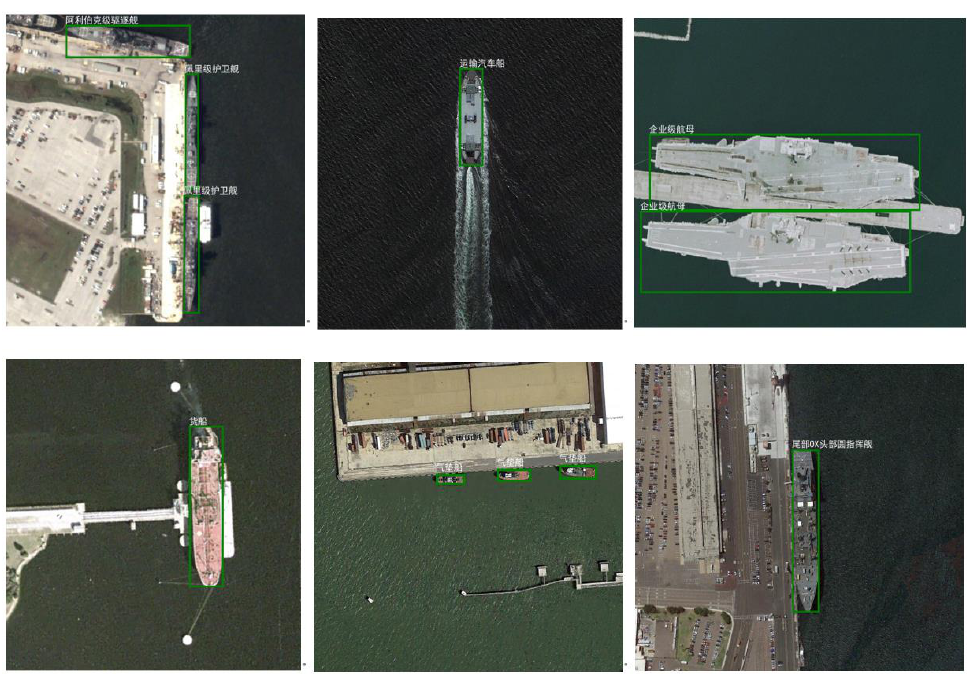
Figure 7. Some of the detection results obtained from the HRSC2016 dataset with our backbone in different state-of-the-art methods.